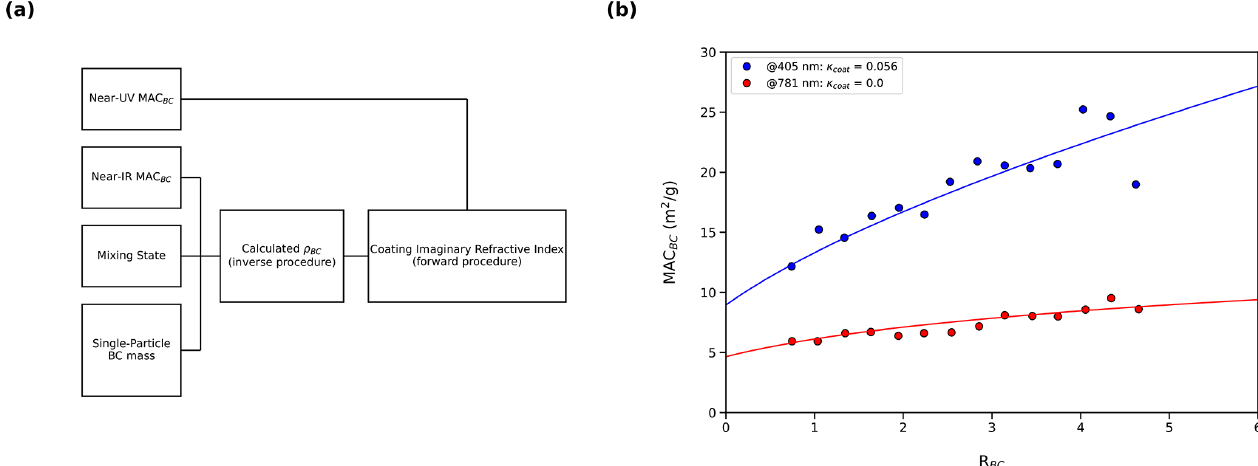
Figure 9. (a) Flowchart for estimation of the coating refractive index. First, ρ BC is determined using the inverse procedure with MAC BC measured at the near-infrared (near-IR) wavelength, where the coating imaginary refractive index ( κ coat ) can be estimated as 0.00. Then, MAC BC at the near-ultraviolet (near-UV) wavelength and calculated ρ BC are input to Eq. (3) and κ coat is calculated using the forward procedure. (b) Example of coating imaginary refractive index retrieval for Liu et al. (2015) (Liu et al., 2015). First, measured MAC BC